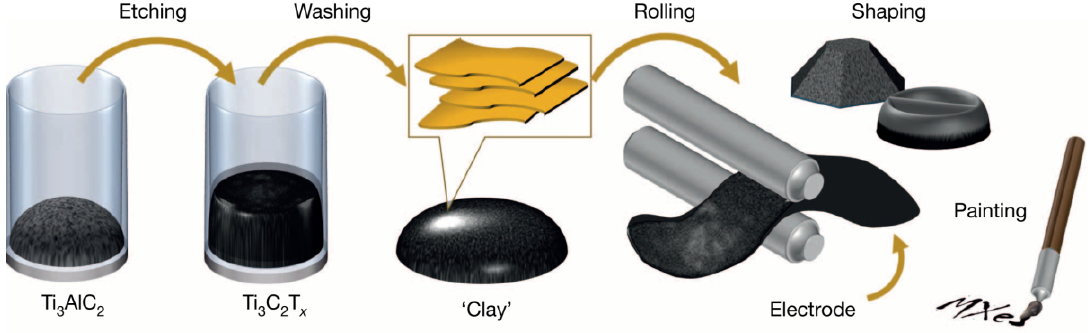
Fig. 12 Ti 3 C 2 MXene clay made by LiF+HCl etching that can be processed by multi-methods to get different shapes. Reproduced with permission from Ref. [115], © Nature Publishing Group, a division of Macmillan Publishers Limited